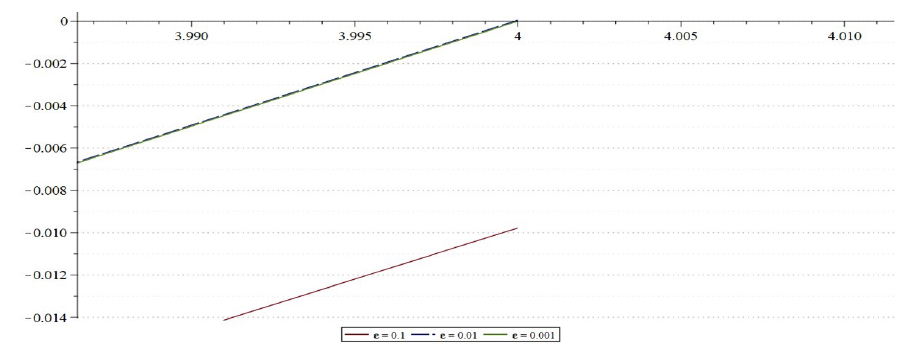
Figure 6. A zoom of z 2 ( 4 ) for varying ε